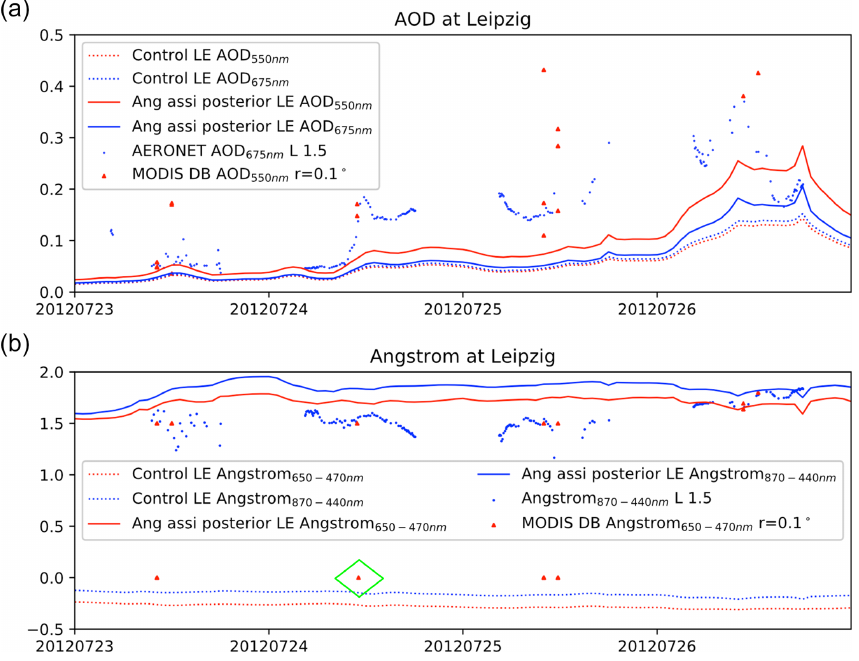
Figure 4. AERONET, MODIS and LOTOS-EUROS prior AOD (a) and Ångström (b) at Leipzig (51 ◦ 21’N, 12 ◦ 26’E). Note that r defines the radius for mapping the MODIS product into the test